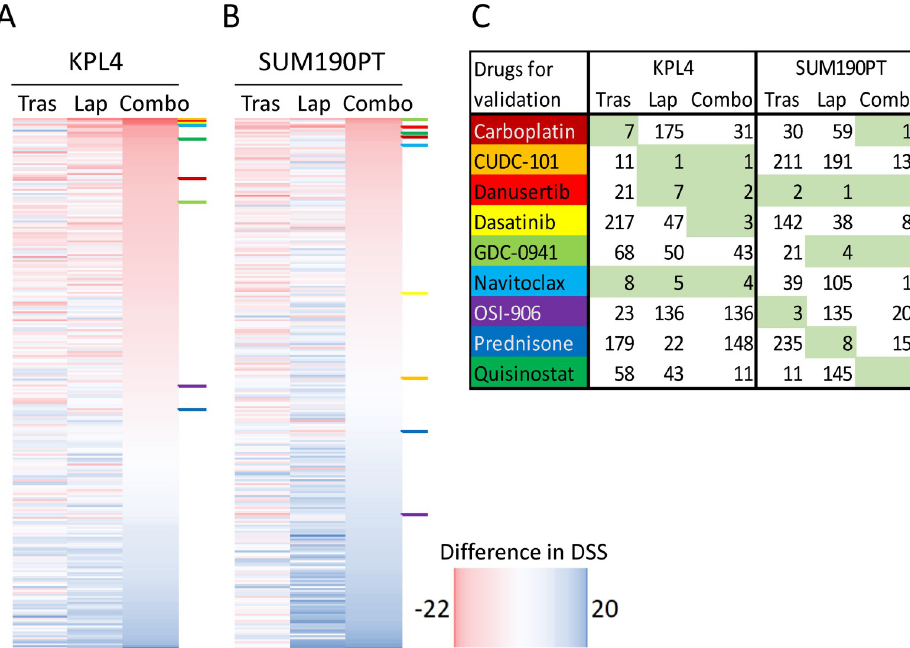
Fig 1. Combinatorial effect of drugs in high-throughput drug screen. Heatmaps displaying the differences in drug sensitivity score (DSS) for 278 drugs screened in combination with trastuzumab (Tras), lapatinib (Lap) and in combination (Combo) compared to drug panel alone in the cell lines KPL4 (A) and SUM190PT (B). The drugs are sorted from the top high (red) to low (blue) combinatorial effect in the respective drug combination column. Combinatorial effect was calculated as the difference in DSS between combination treatment and the drugs alone giving a negative score if high effects were obtained. Panel (C) lists the drugs selected for further validation. Their position in the heatmaps (A+B) is indicated using the corresponding colors. The table shows combinatorial effect rank numbers of the nine selected drugs within each treatment group (among all drugs in the screen). Each selected drug was ranked within top ten in at least one treatment group, as highlighted by the green